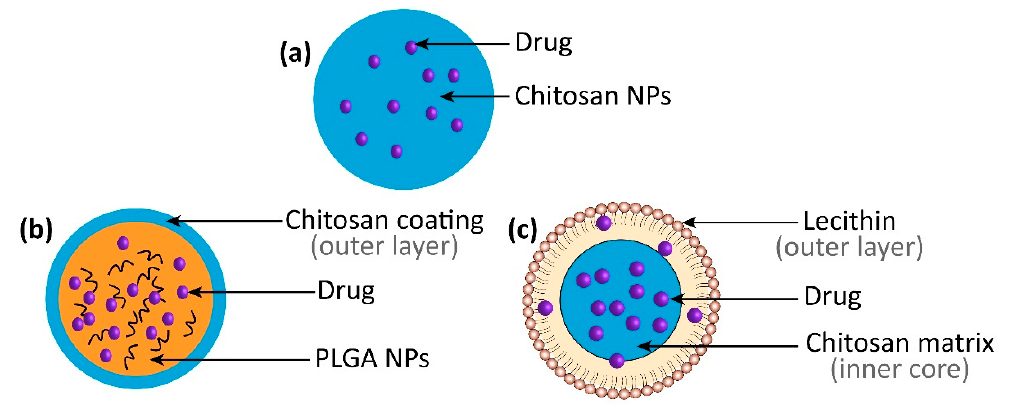
Figure 6. Different types of chitosan-based nanomedicines. ( a ) Chitosan NPs. ( b ) Chitosan-coated NPs. ( c ) Chitosan-based hybrid NPs. NPs. ( c ) Chitosan-based hybrid